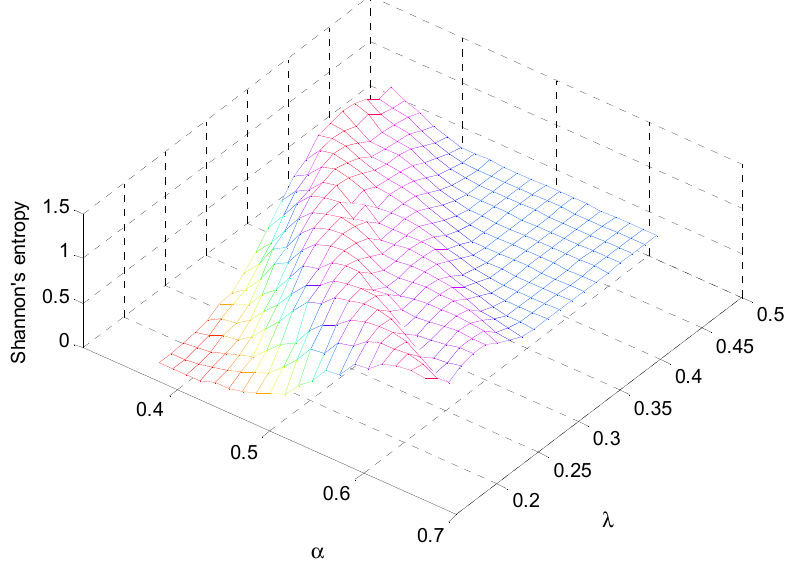
Figure 5. Distribution of the Shannon’s Index computed on the simulated vegetation patterns as a function of the climatic conditions described by the rainfall parameters α and λ